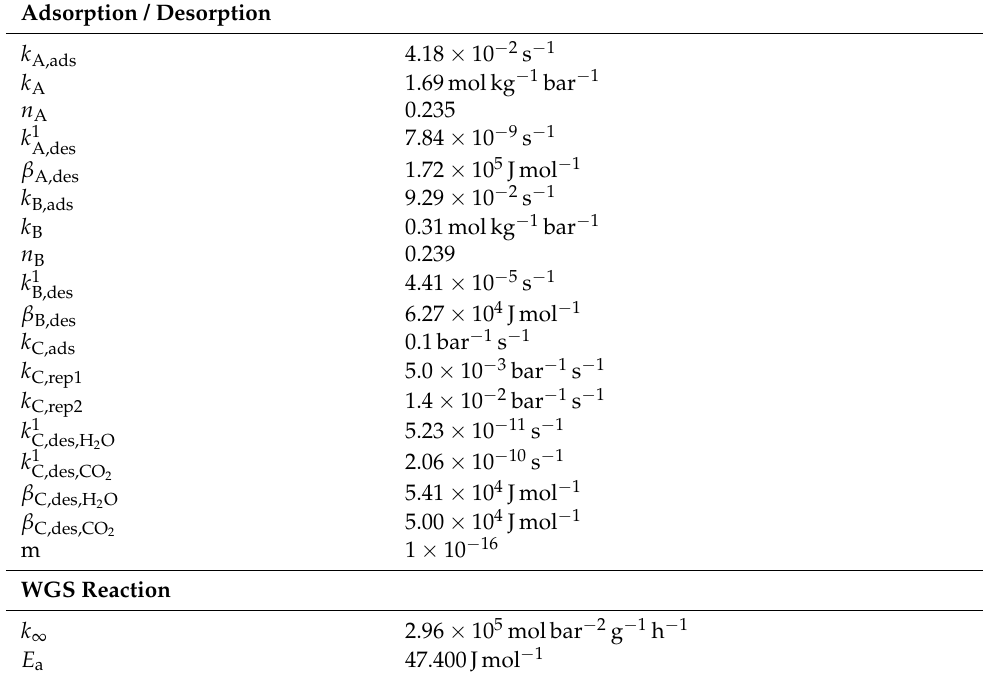
Table A1. Kinetic coefficients. Adapted from [28,29].